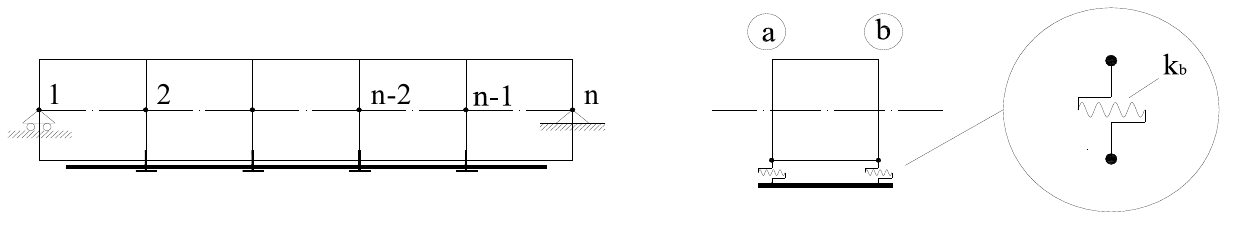
Figure 2. Key components of the proposed 1D